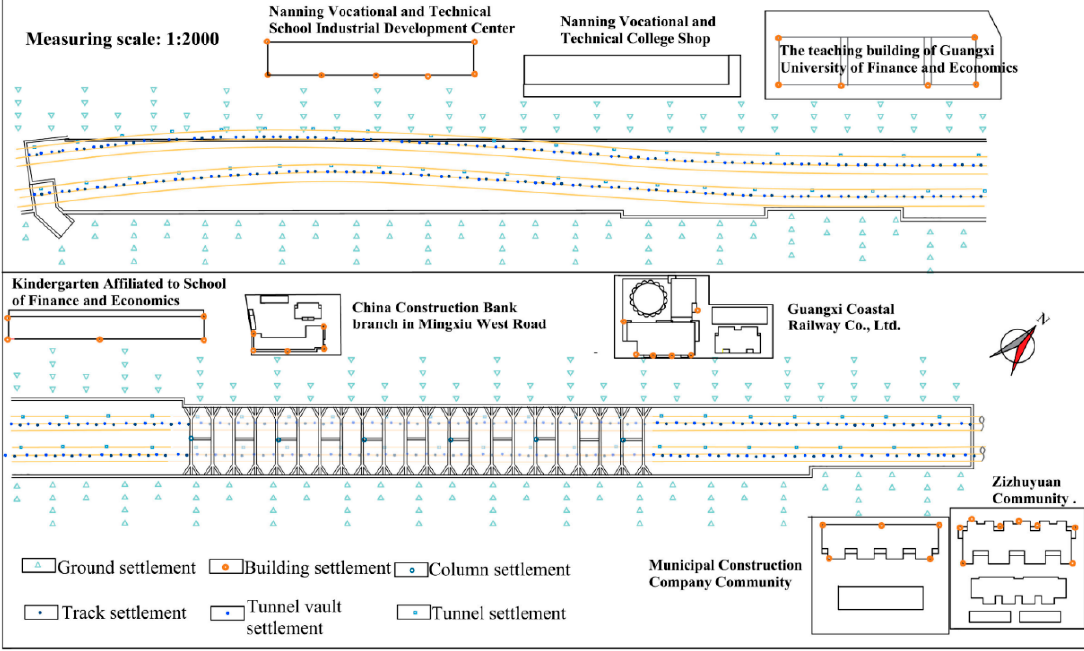
Figure 7. The layout of monitoring points for the comprehensive underground utilization project of Guangxi University of Finance and Economics.